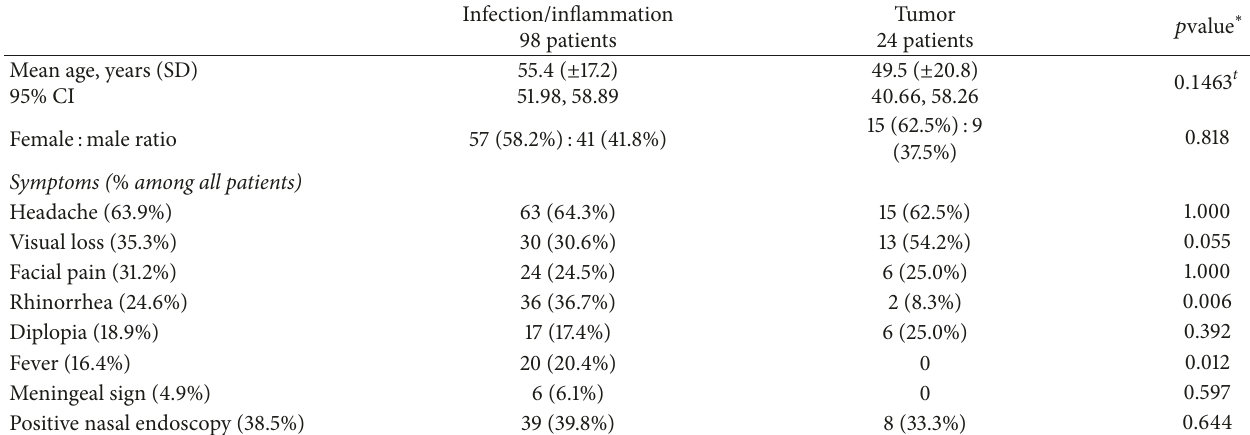
Table 2: Characteristics of the infection/inflammation and tumor groups.